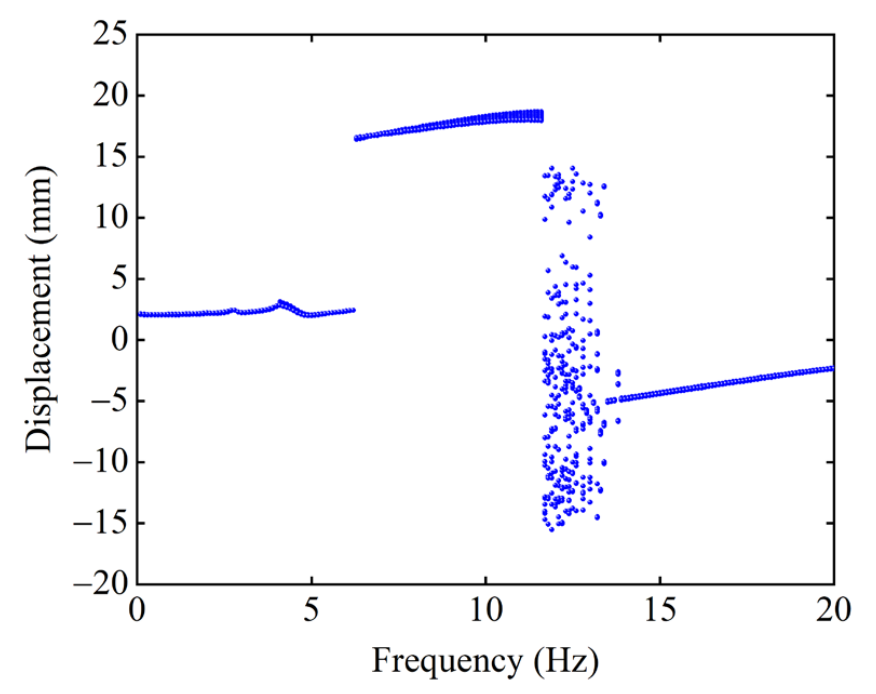
Figure 12. Excitation frequency–displacement bifurcation diagram of the system.